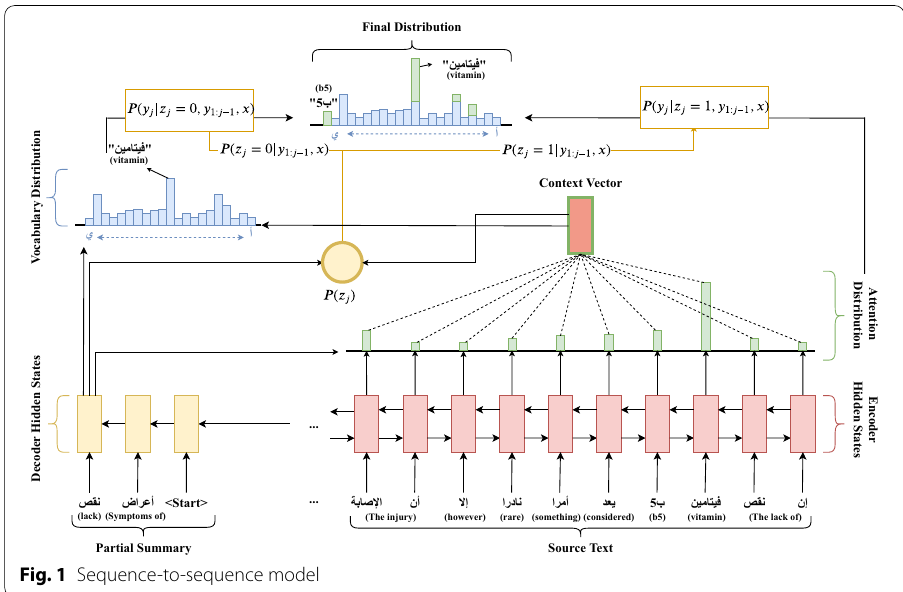
Fig. 1 Sequence‑to‑sequence